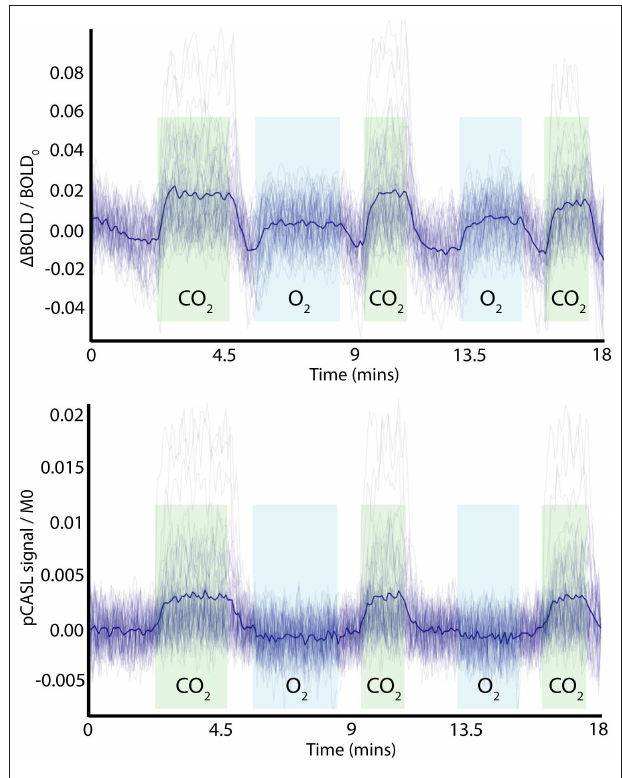
FIGURE 1 | Example of simulated time-domain data (BOLD and ASL) with added noise and variation in physiological parameters, showing periods of hypercapnic (green) and hyperoxic (light blue) stimuli. The dark blue line represents the mean time-course over the example time series. Note the pCASL signal is normalized by the equilibrium magnetization of arterial blood (MO) and has had the baseline signal subtracted for display